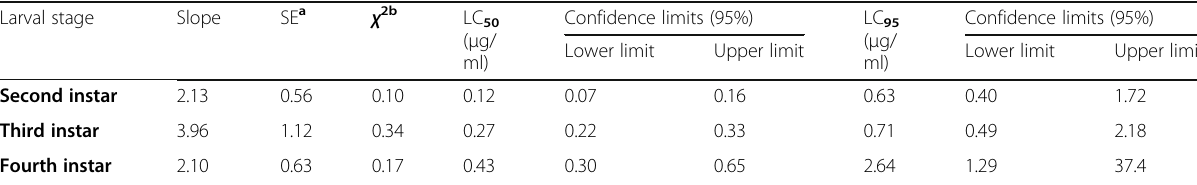
Table 1 Toxicity of Cry1Ac protein from Bacillus thuringiensis to 2nd, 3rd, and 4th larval instars of tomato pinworm, Tuta absoluta Larval stage Slope